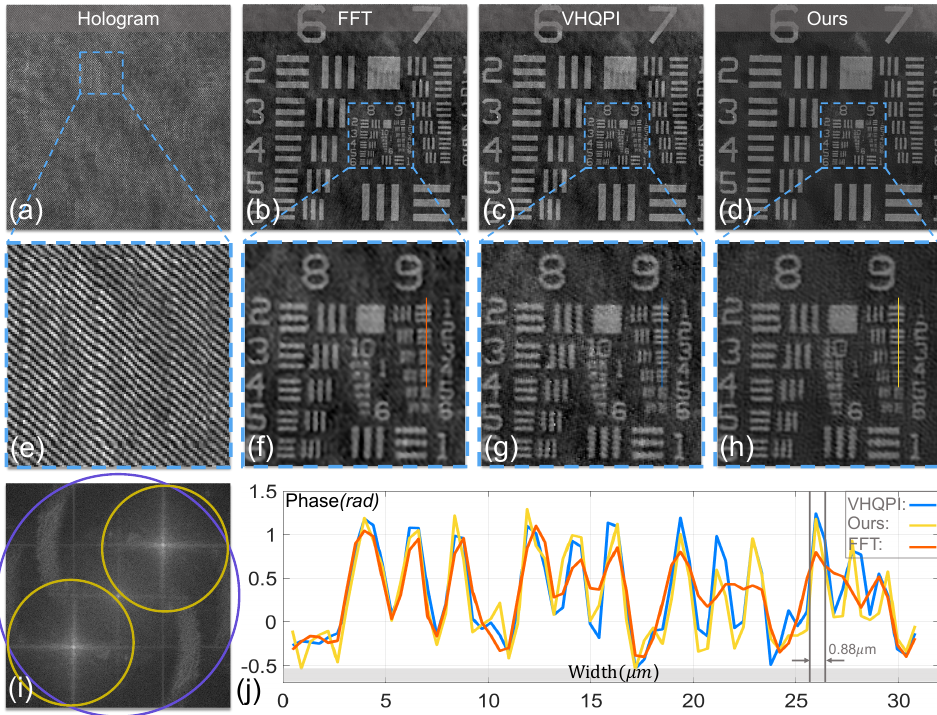
Figure 5. The experiment results for the standard phase resolution target. ( a ) The captured hologram, a zoomed portion of which is shown in ( e ). ( b ) The based-FT phase result. ( c ) The phase recovered by the VHQPI. ( d ) The result is covered by our method. ( f – h ) The detailed views of ( b – d ) quantitatively demonstrate the artifacts-suppression capability and imaging resolution of the three methods. ( i ) The corresponding spectrum of ( a ) and its SBU can reach 53.9% (the blue circle indicates 0-order and the yellow circles indicate ± 1-order.). ( j ) The cross-section of the phase results of the FT, VHQPI, and our